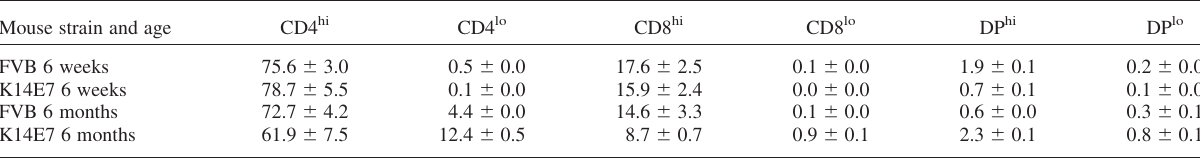
TABLE I Expression of CD4 and CD8 on LN cells expressing high levels of